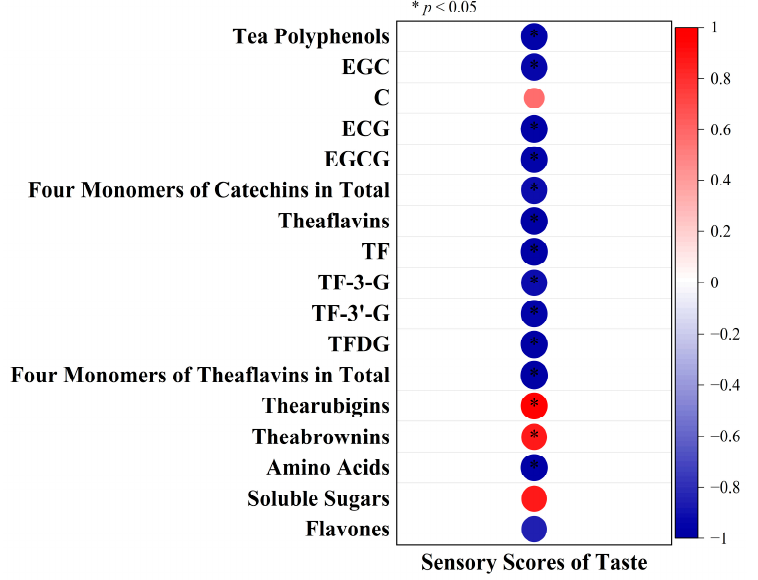
Figure 4. Correlation analyses between taste sensory scores and compounds, with red for positive correlation and blue for negative correlation; darker color and larger circle area indicate larger correlation coe ffi cient; * indicates signi fi cant di ff erence at p < 0.05.